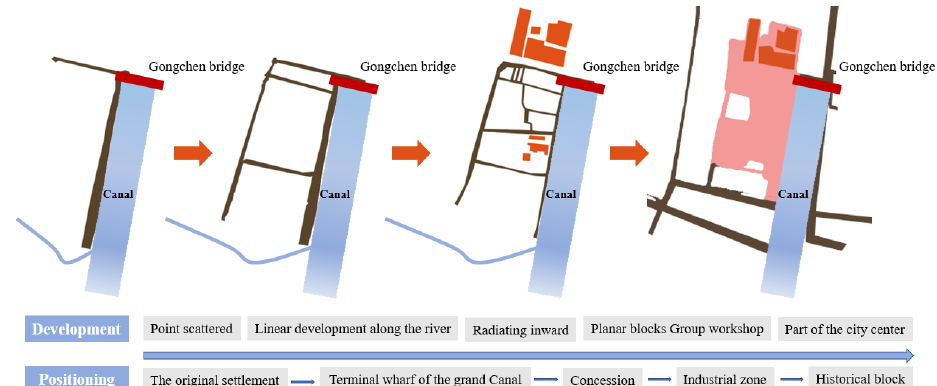
Figure 5. Morphological evolution of Gongchen Bridge Block. (Self-painted according to the historical evolution of Gongchen Bridge).